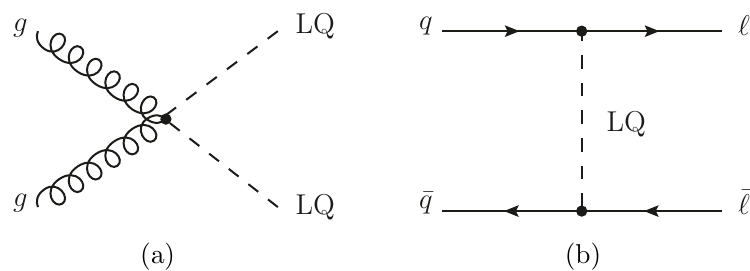
Figure 3 . (a) Representative Feynman diagram for LQ pair production via QCD interactions. (b) Feynman diagram for LQ t -channel exchange in pp ! ‘ (cid:22) ‘ production at the LHC. The dashed propagator represents either a scalar or vector LQ